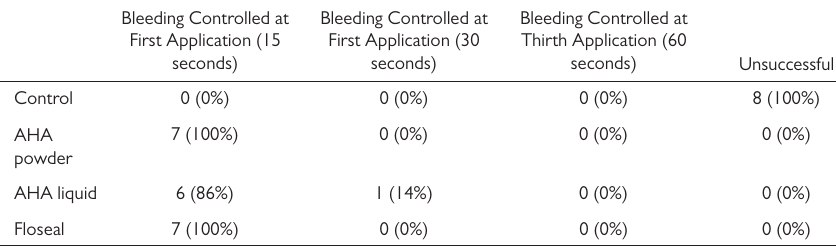
Table 1. Control and Homeostasis Times of Groups